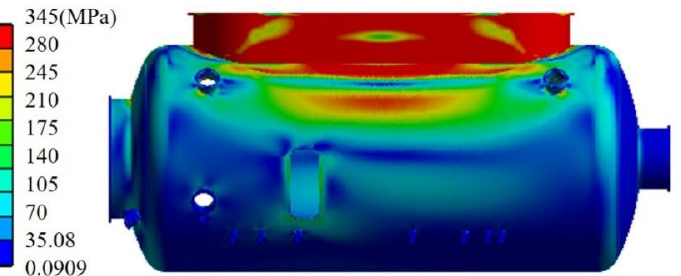
Figure 9. Contours of the von Mises stress distribution of the test cabin without reinforcement ribs under limit load.